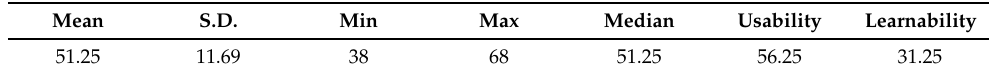
Table 3. SUS scores: non-objective group.